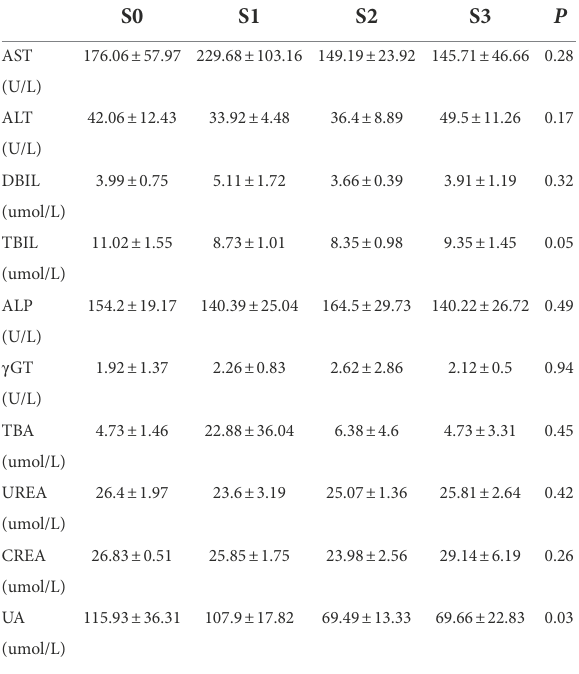
TABLE 5 Clinical chemistry results of 28-day repeated dose